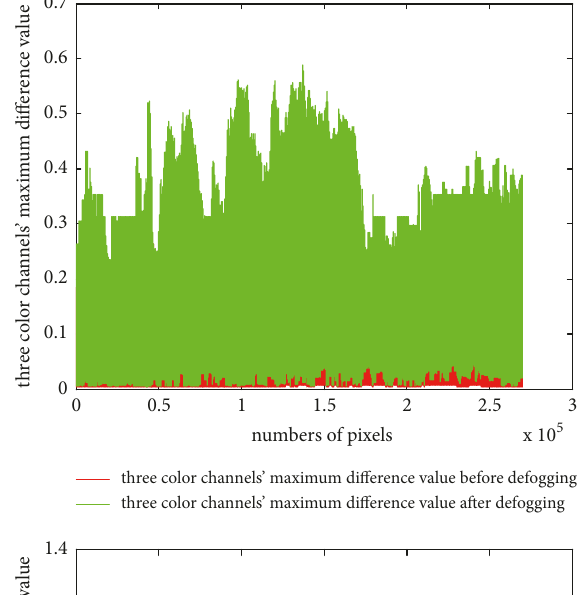
three color channels’ maximum difference value before defogging three color channels’ maximum difference value after defogging